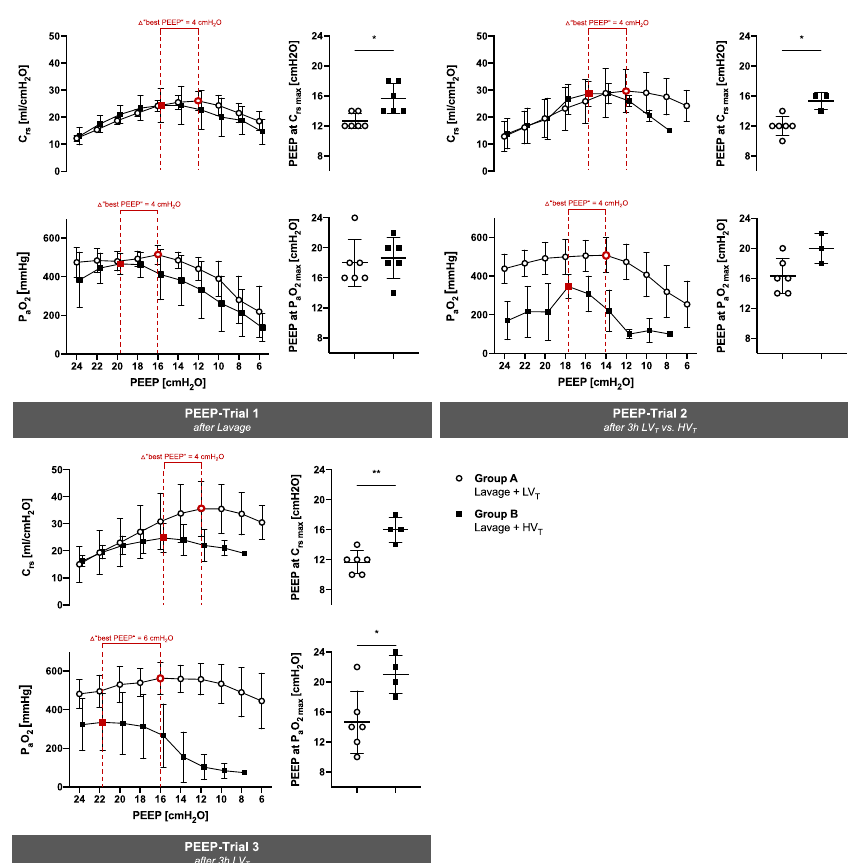
Fig. 4 Decremental PEEP trials: identification of “best PEEP ”. PEEP trials with decrements of 2 from 24 to 6 cmH 2 O were performed at three instances following a recruitment maneuver (RM) in anesthetized pigs which had undergone combined lavage-induced surfactant depletion and therapeutic ventilation. Group A, N 6: continuous automated protective low tidal volume ventilation (LV T ). Group B, N = high tidal volume ventilation (HV T ) prior to PEEP trial 2, resumption of protective low tidal volume ventilation for 3 h prior to PEEP trial 3. Two animals died after injurious HV T and RM 2, i.e., Group B, N and 3. For experimental protocol, see Fig. 1 and “Methods” Section. Line graphs depict the group means of C rs and P a O 2 obtained at each PEEP level. PEEP values at the maximum mean C rs and maximum mean P a O 2 (red vertical dotted lines) are consistently disparate within each group and differ between groups. Adjacent scatter plots depict the PEEP values at maximum C rs and P a O 2 of each individual animal and the means thereof. * p < 0.05, ** p < 0.01, Mann–Whitney U